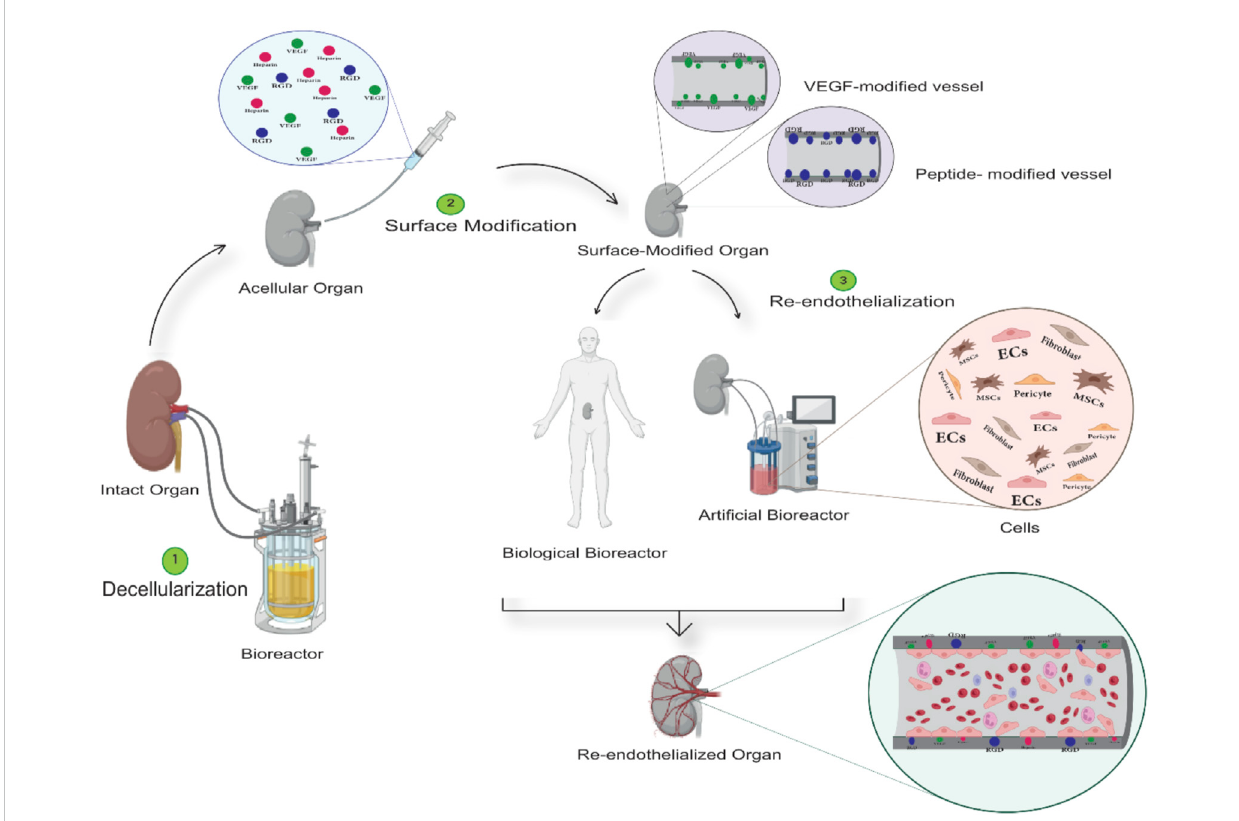
FIGURE 1 General structure of tissue decellularization and re-endothelialization procedures. In the fi rst stage (Step 1), the decellularizing agents, such as detergents, areinjected into thetarget tissue usingbioreactors.The acellular structure isobtained by controlling settings suchas materialconcentration, time and temperature, etc. In the second stage (Step 2), the acellular structure obtained gets modi fi ed by bioactive molecules to minimize the damages caused by the decellularization process and improve the vascular structure ’ s endothelialization outcome. Ultimately, in the process of endothelialization(step 3),arti fi cialand biologicalbioreactors areemployedtouse generated fl owand cell cocktails, respectively, orby transplantingthe structure to a living organism and using its blood fl ow and progenitor cells to cover the intended vascular structure with the endothelial